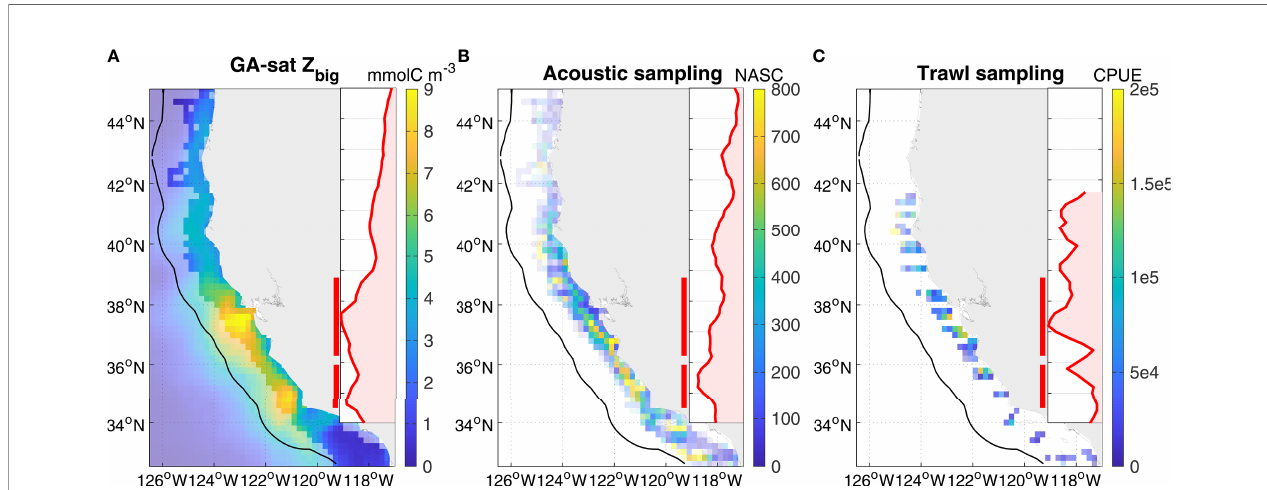
FIGURE 5 | GA-sat krill springtime spatial pattern evaluation against in situ surveys. All panels are May/June averages, and display as an insert the latitudinal pro fi le averaged in the 150 km coastal band (black contour). Red bars indicate the central and southern hotspots (northern hotspots occur later in the year). (A) GA-sat restricted to non-NRT years; pixel transparency indicates the region sampled in situ . (B) Acoustic and (C) trawl in situ data averaged onto the GA-sat grid (data restricted to 2004-2019 when surveys expanded beyond the central region); pixel transparency is inversely proportional to the number of years sampled at each grid cell.